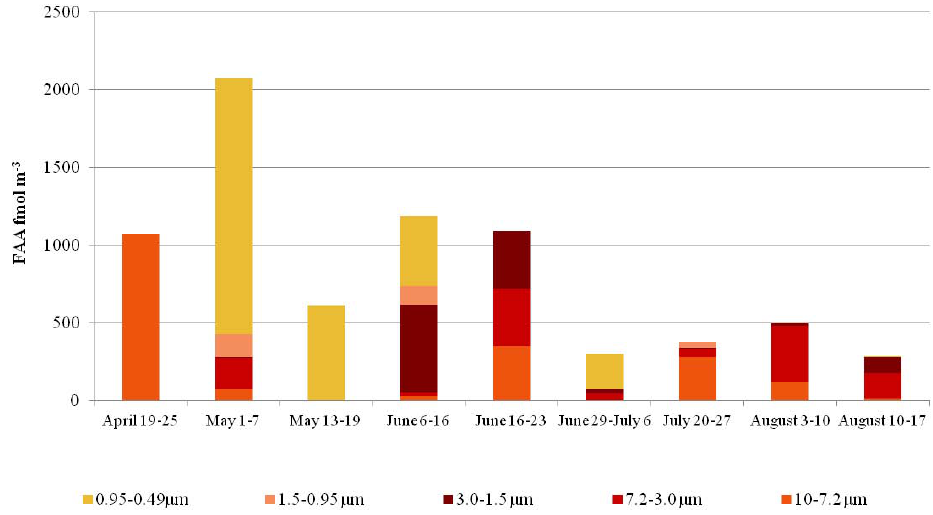
Fig. 3. Total amino acid size distributions in the five stages of completely analyzed